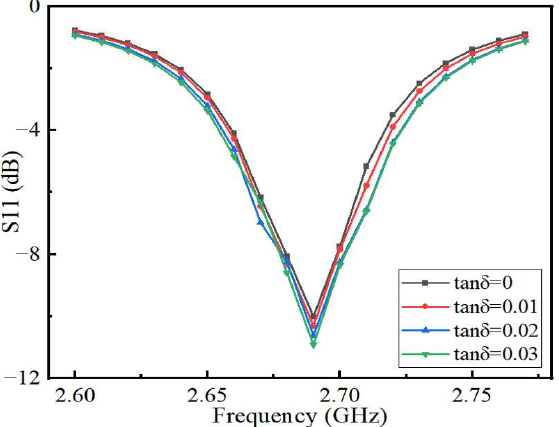
Figure 8. The relationship between S11 parameters of sensor and the variation of dielectric loss tangent angle of microchannel.